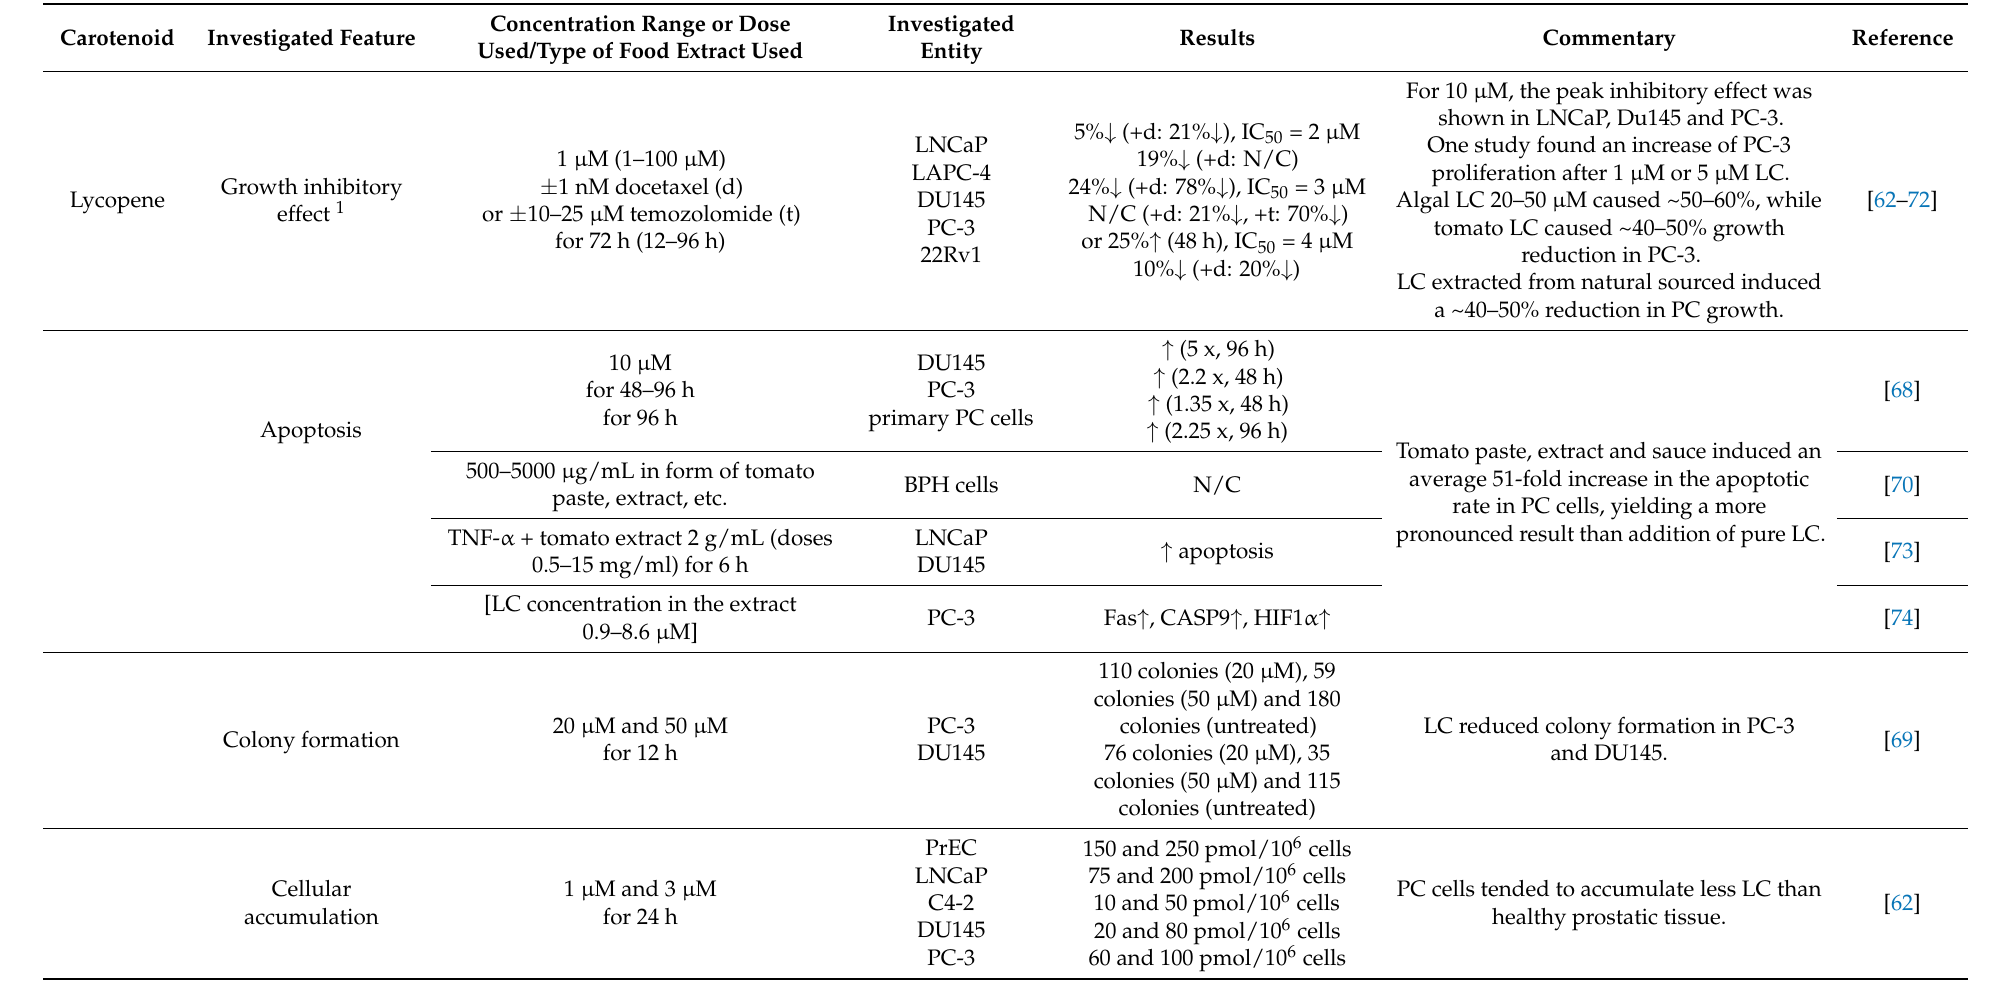
Table 3. Overview of results of laboratory studies investigating the impact of carotenoids on prostate cancer (PC) (cell lines, PC tissue or mice model).